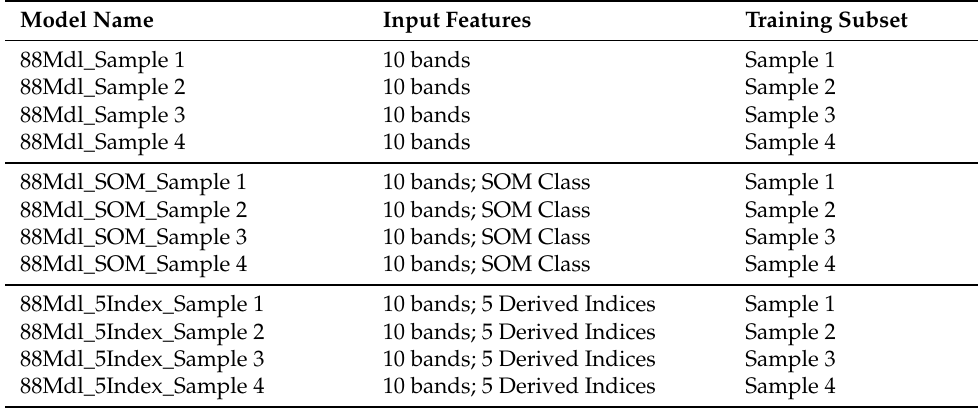
Table 3. Model names and